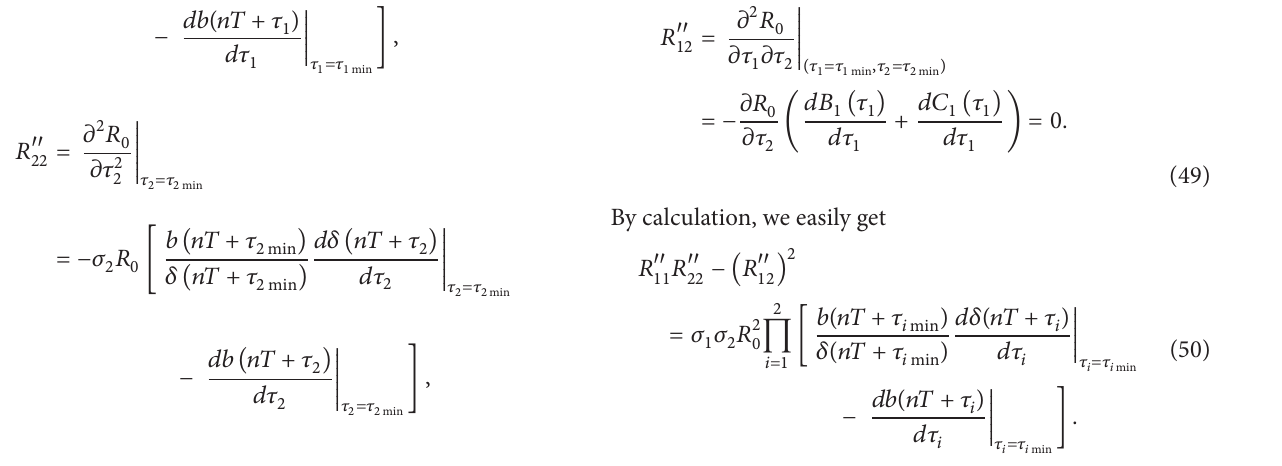
𝜎 𝑅 1 on 0 ; (c) the effect of pest killing rate